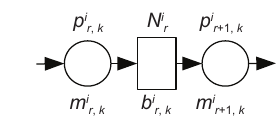
Fig. 6 Two-machine